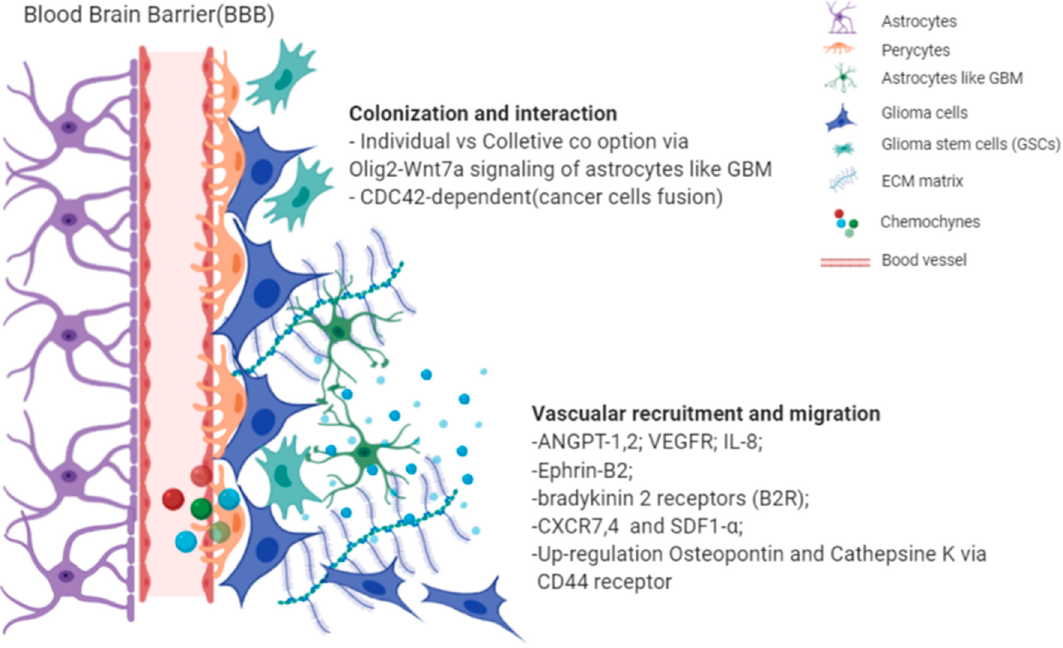
Figure 7. Illustrative picture of perivascular satellites events and major molecular mechanisms, which explain the interaction between endothelial cells from BBB and glioma cells. Images are created with BioRender.com